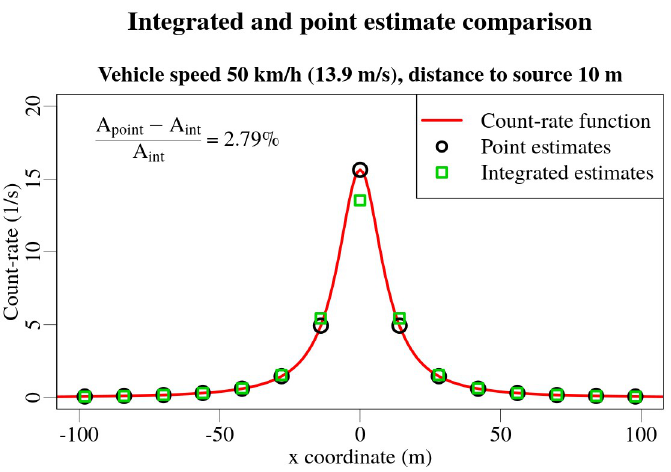
Fig 4. Comparison of point vs integrated estimates of measurement values of mobile gamma spectrometry data when the source is positioned at 10 m. The red line denotes the countrate function in the detector, black circles mark the point estimates and green squares—integrated estimates. Relative difference of the areas under the point and integrated estimate peaks is 2.79%.